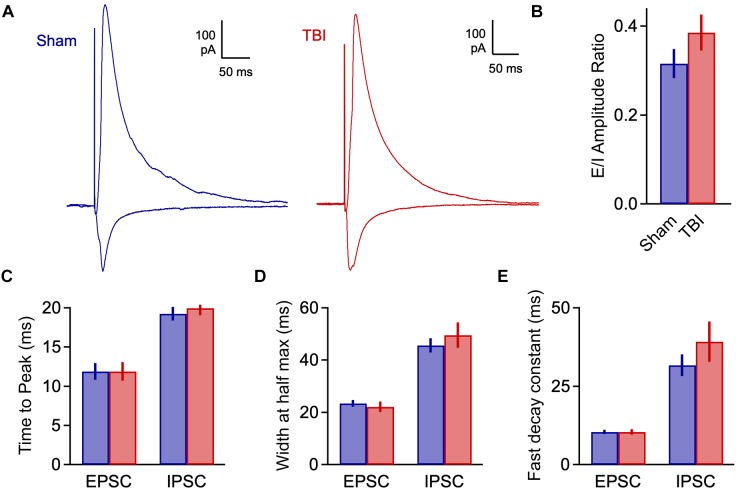
Excitatory-inhibitory balance remains stable at 48 h post-injury. (A) Excitatory and inhibitory inputs in the same piriform pyramidal cell upon electrical stimulation of the LOT. (B) The ratio of excitatory to inhibitory amplitudes was largely unchanged at 48 h after TBI [0.316 ± 0.033 vs. 0.386 ± 0.040 for sham and TBI; p = 0.185; t(29) = –1.357; t-test; n = 9 mice, 16 cells for sham; 9 mice, 15 cells for TBI]. (C) Response kinetics (time to peak) were unchanged for both EPSCs and IPSCs [EPSCs: 11.9 ± 1.0 vs. 11.9 ± 1.2 ms for sham and TBI; p = 0.630; t(26) = 0.488; t-test; IPSCs: 19.3 ± 0.9 vs. 20.0 ± 0.9 ms for sham and TBI; p = 0.580; t(27) = –0.56; t-test]. (D,E) Duration (width at half max) and decay kinetics were also unchanged [half width – EPSCs: 23.4 ± 1.3 vs. 22.0 ± 2.0 ms for sham and TBI; p = 0.294; t(26) = 1.07; t-test; IPSCs: 45.6 ± 2.8 vs. 49.5 ± 4.9 ms; p = 0.491; t(27) = –0.699; t-test; decay time – EPSCs: 10.4 ± 0.7 vs. 10.4 ± 0.8 ms; p = 0.308; t(26) = 1.040; t-test; IPSCs: 31.6 ± 3.5 vs. 39.2 ± 6.4 ms; p = 0.302; t(27) = –1.051; t-test]. For EPSC kinetics, n = 9 mice, 14 cells for sham; 9 mice, 15 cells for TBI; for IPSC kinetics, n = 9 mice, 13 cells for sham; 9 mice, 14 cells for TBI.